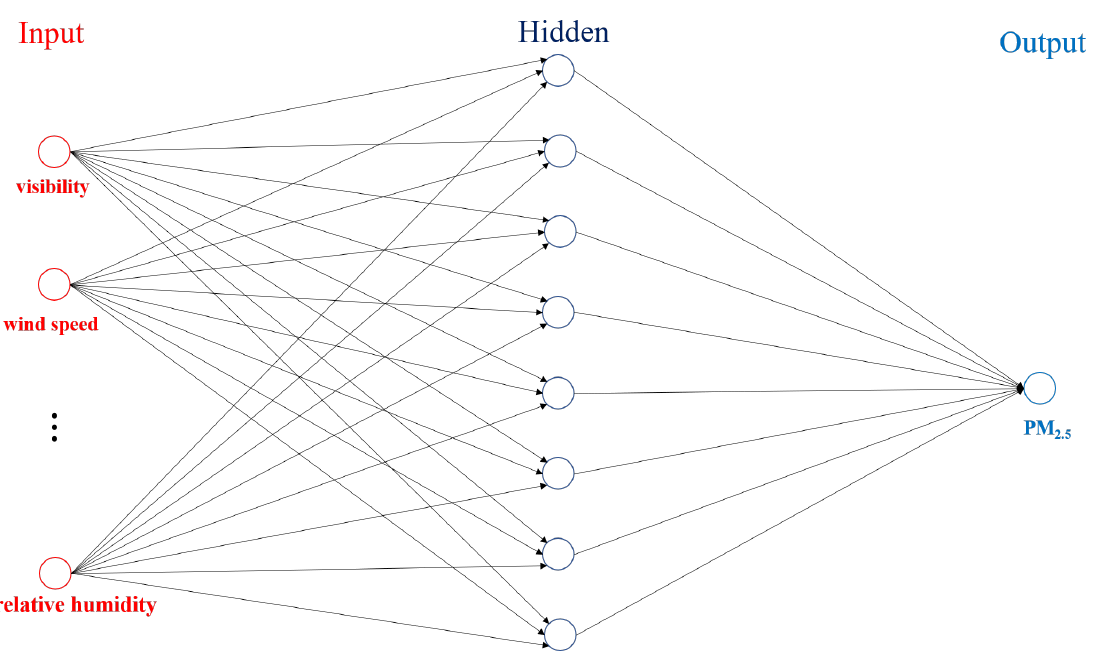
Figure 4. This figure shows a conceptualized diagram of two-layer feed-forward network that used for predicting PM